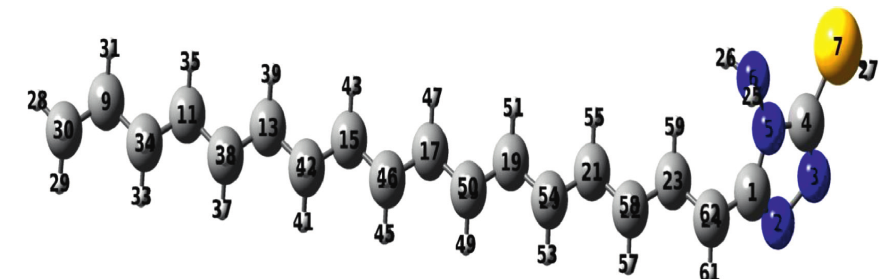
Figure 4: Numbering system for triazole ligand.